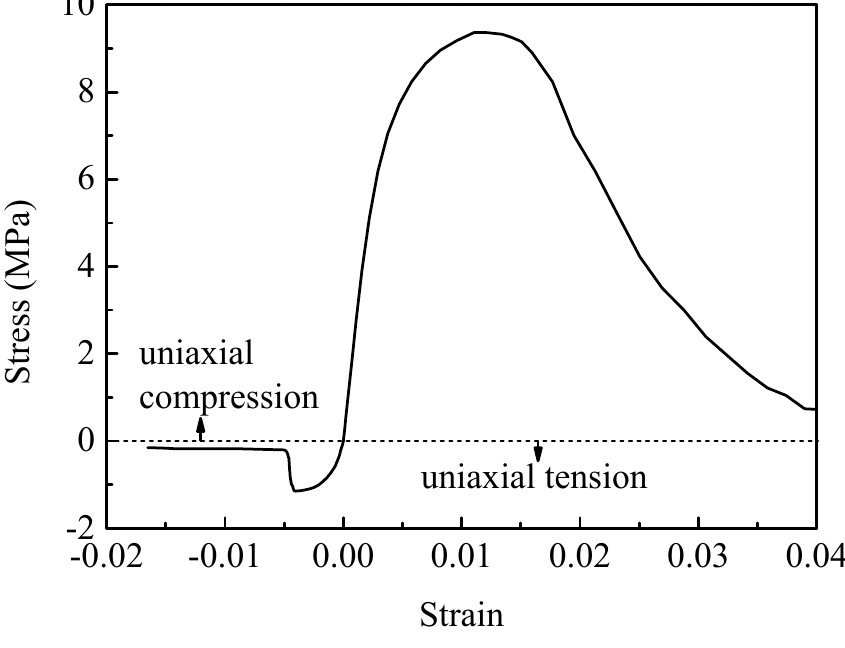
Figure 19. Compressive stress–strain curve of PBX 9501 at a strain rate of 10 − 3 s − 1 .